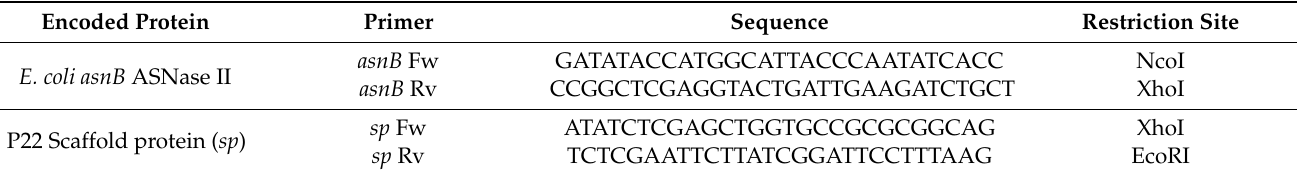
Table 1. Primers used for asnB-sp